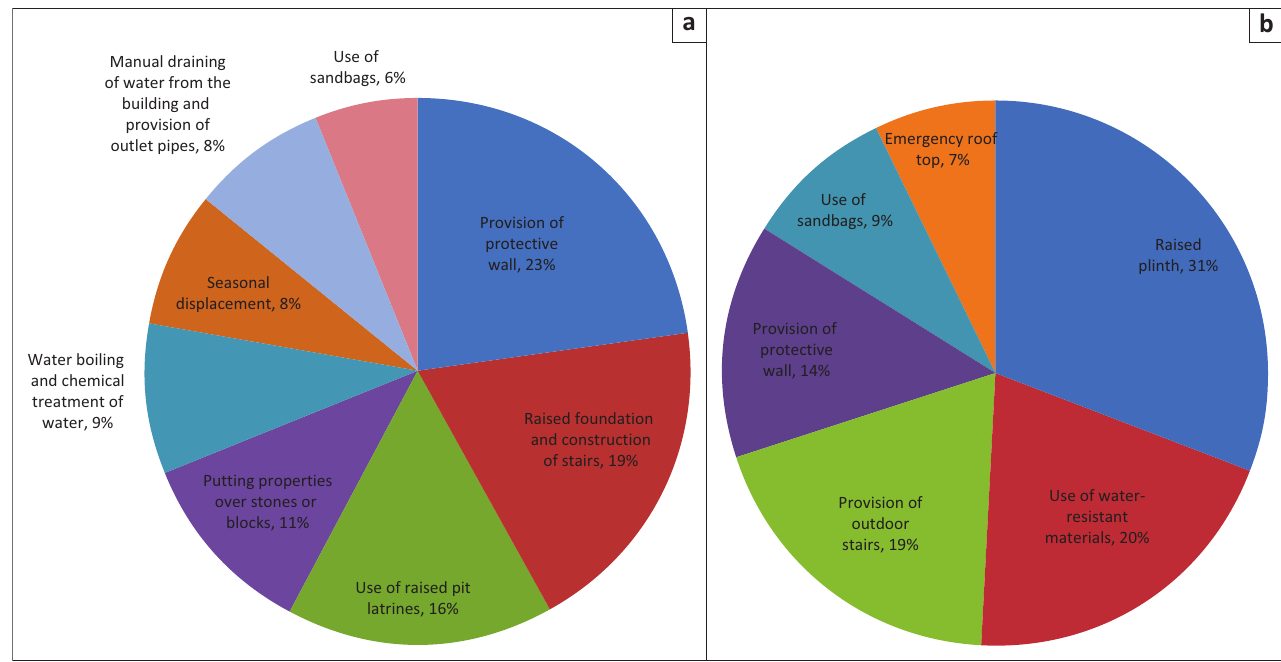
FIGURE 3: Adaptation strategies at household level for, (a) Keko Machungwa and (b) Sangkrah informal settlements.